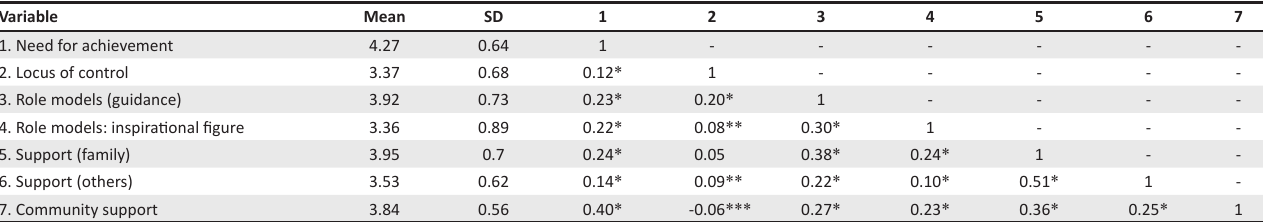
TABLE 2: Descriptive statistics and correlations of factors. Variable